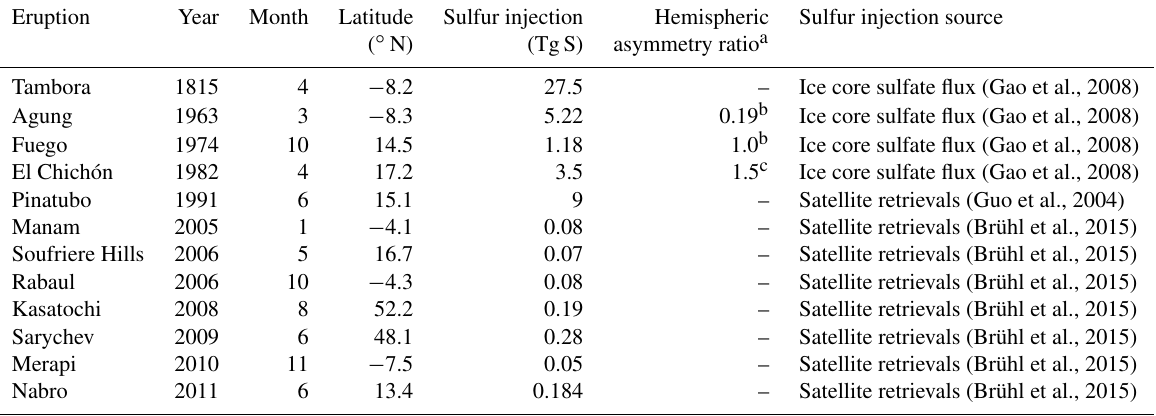
Table 1. Stratospheric sulfur injection estimates used in this work. Eruption Year Month Latitude Sulfur injection Hemispheric Sulfur injection source ( ◦ N) (TgS) asymmetry ratio